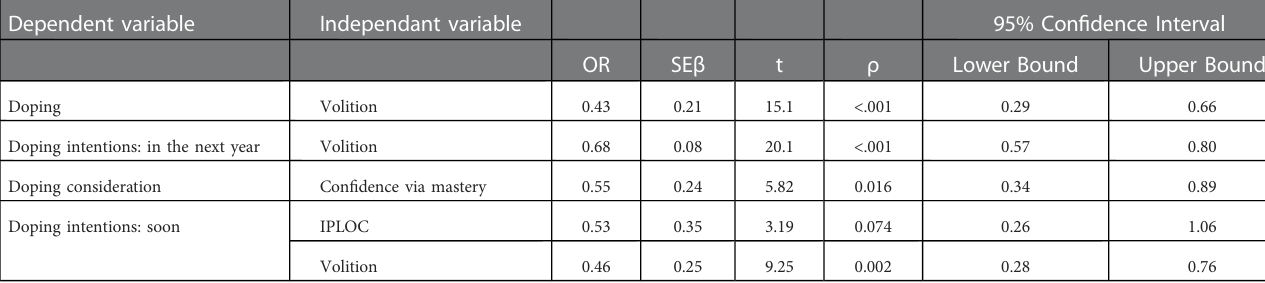
TABLE 3 Summary of models that that decrease the odds of doping, doping intentions and doping consideration among adolescent athletes.*. Dependent